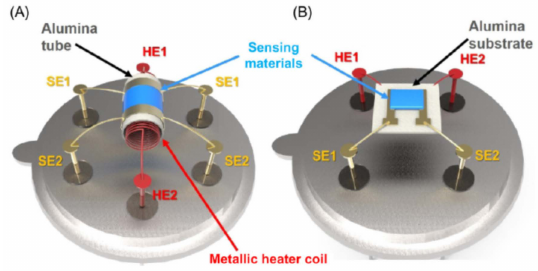
Figure 3. Schematic structure of ( A ) tube-type and ( B ) substrate-type oxide semiconductor sensors (SE, sensor electrode; HE, heater electrode). Reprinted with permission from [34]. Copyright Elsevier, 2019.